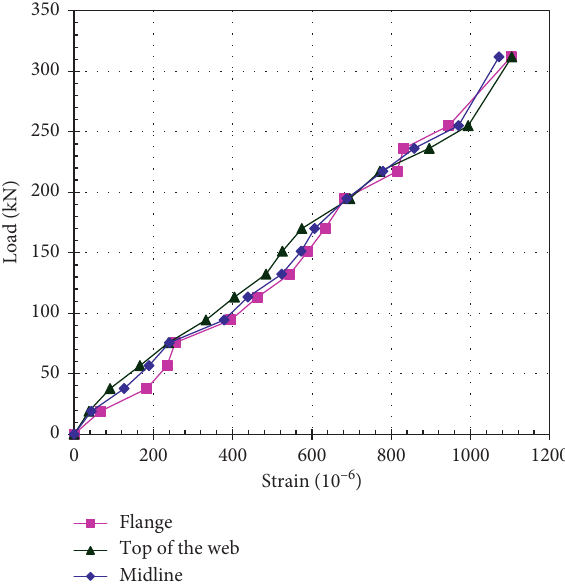
Figure 25: PLG-2 strain of midspan reinforcement after 1.25 million dynamic loads.